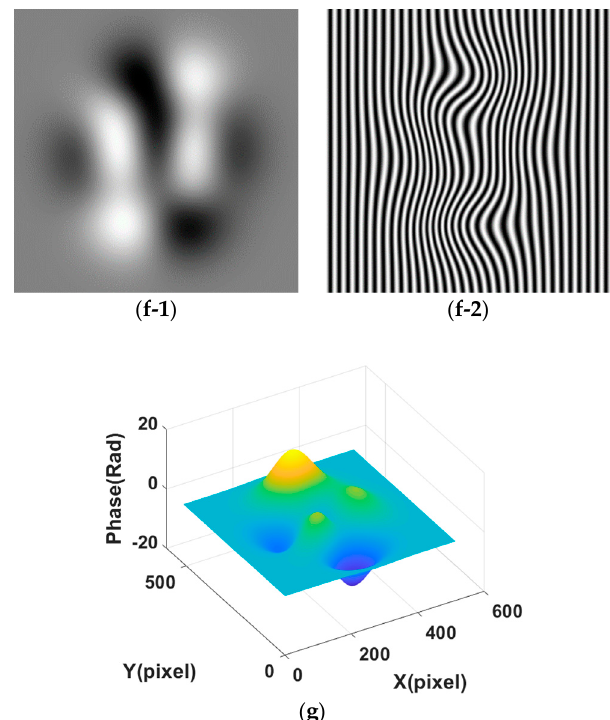
Figure 2. Simulated projection fringe patterns of peaks shape. ( a ) Fringe pattern with frequency 1/8 without noise added; ( b ) Fringe pattern with frequency 1/16 without noise added; ( c ) Fringe pattern with frequency 1/8 with Gaussian noise added; ( d ) Fringe pattern with frequency 1/16 with Gaussian noise added; ( e-1 ) The ground truth background part of Figure 2a,c; ( e-2 ) The ground truth fringe part of Figure 2a,c; ( f-1 ) The ground truth background part of Figure 2b,d; ( f-2 ) The ground truth fringe part of Figure 2b,d; ( g ) The ground truth phase.